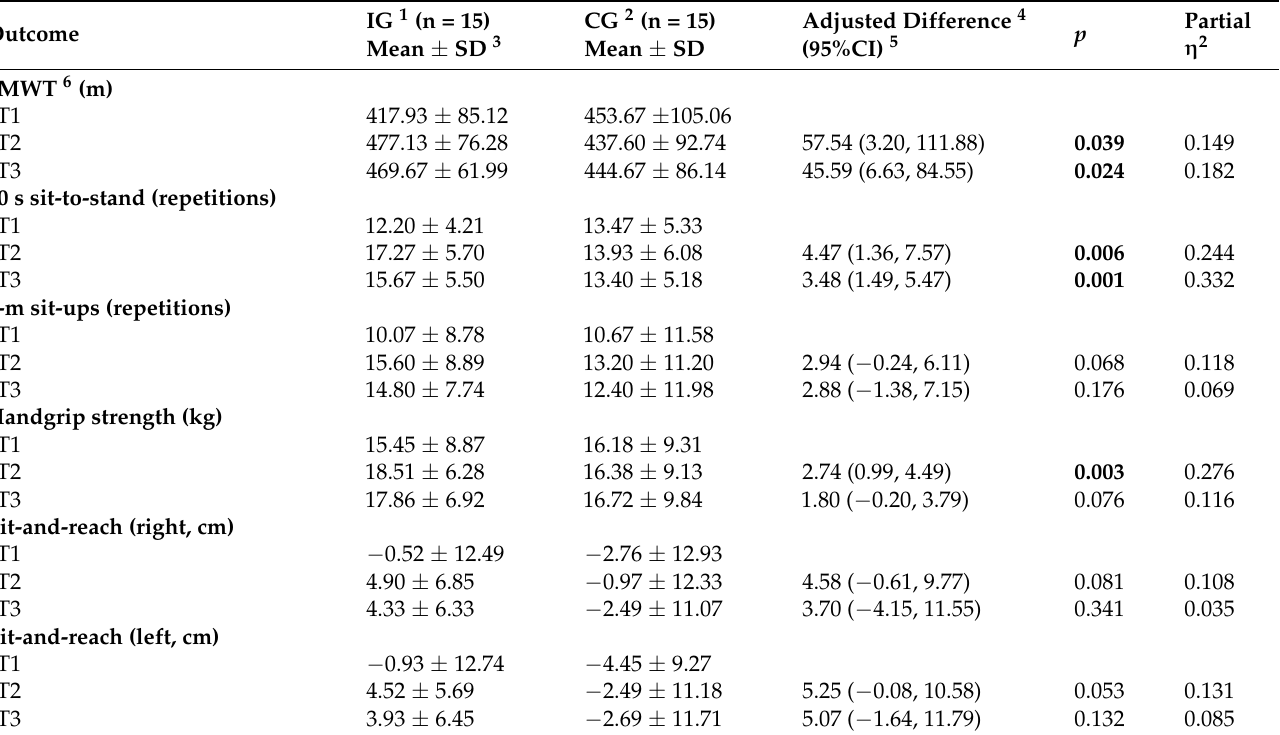
Table 6. Between-group differences in HRPF-related